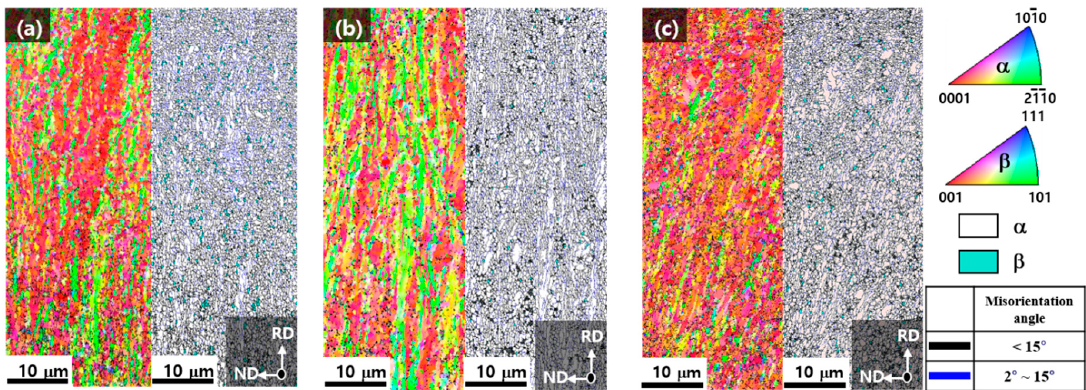
Figure 2. Electron backscatter diffraction (EBSD) inverse pole figure map and corresponding phase map of the samples: ( a ) STEP-0, ( b ) STEP-5, ( c ) STEP-6.